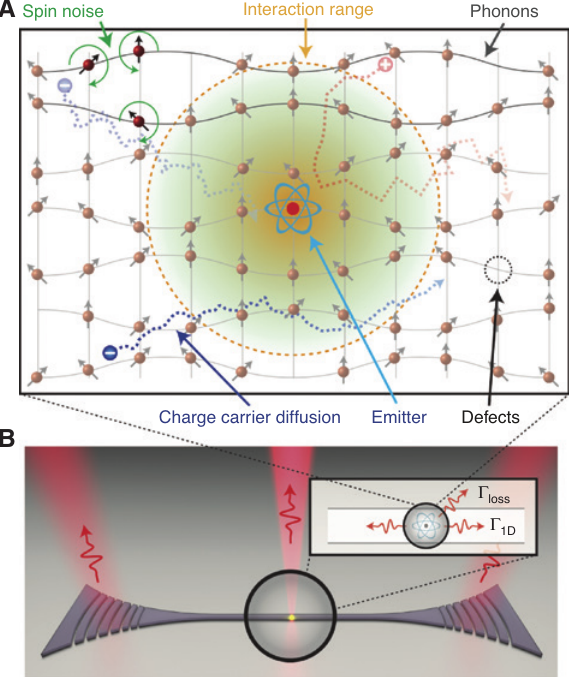
Figure 1: The basic system considered in this review: a quantum emitter coupled to a quasi-one-dimensional photonic waveguide. The coherence of this quantum system is degraded by the interaction of the emitter with the solid-state environment, as discussed in the text. (A) Here, sources of noise such as charge, spin, phonons, and nearby defects are schematically depicted. (B) Emission, in this system, occurs either into the guided modes, with a rate Γ , or is lost into other modes with a rate Γ 1D loss